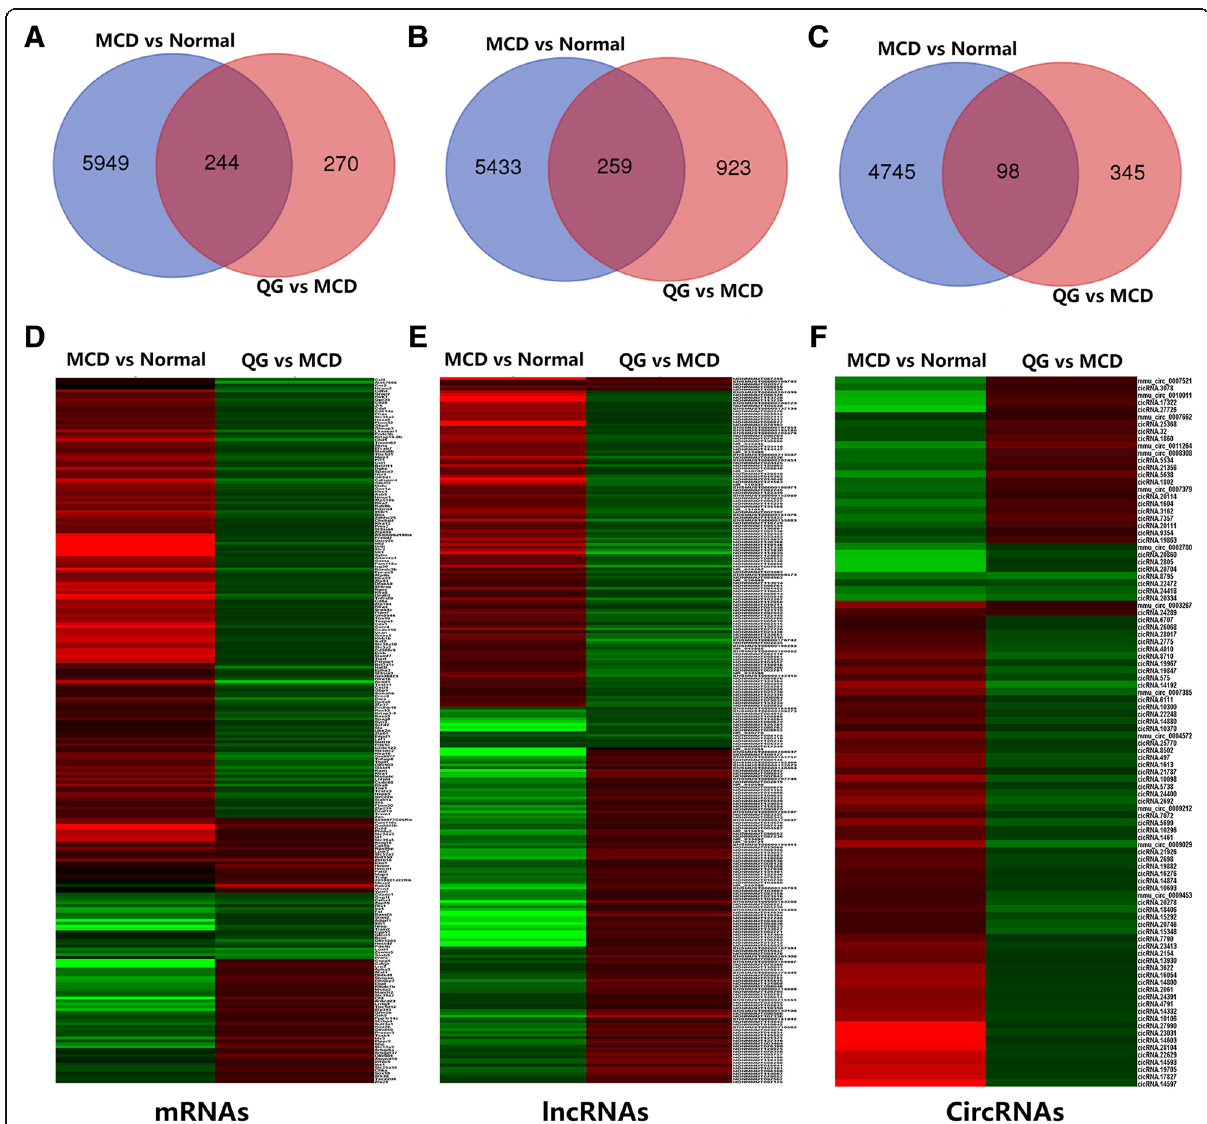
Fig. 2 Hierarchical cluster of overlapped DEGs, DElncRNAs and DEcircRNA. a Venn diagram of overlapping DEGs. b Venn diagram of overlapping DElncRNAs. c Venn diagram of overlapping DEcircRNAs. d Heatmap of overlapping DEGs. e Heatmap of overlapping DElncRNAs. f Heatmap of overlapping DEcircRNAs. Gene expression is represented by colors, with brighter red for higher values and brighter green for lower